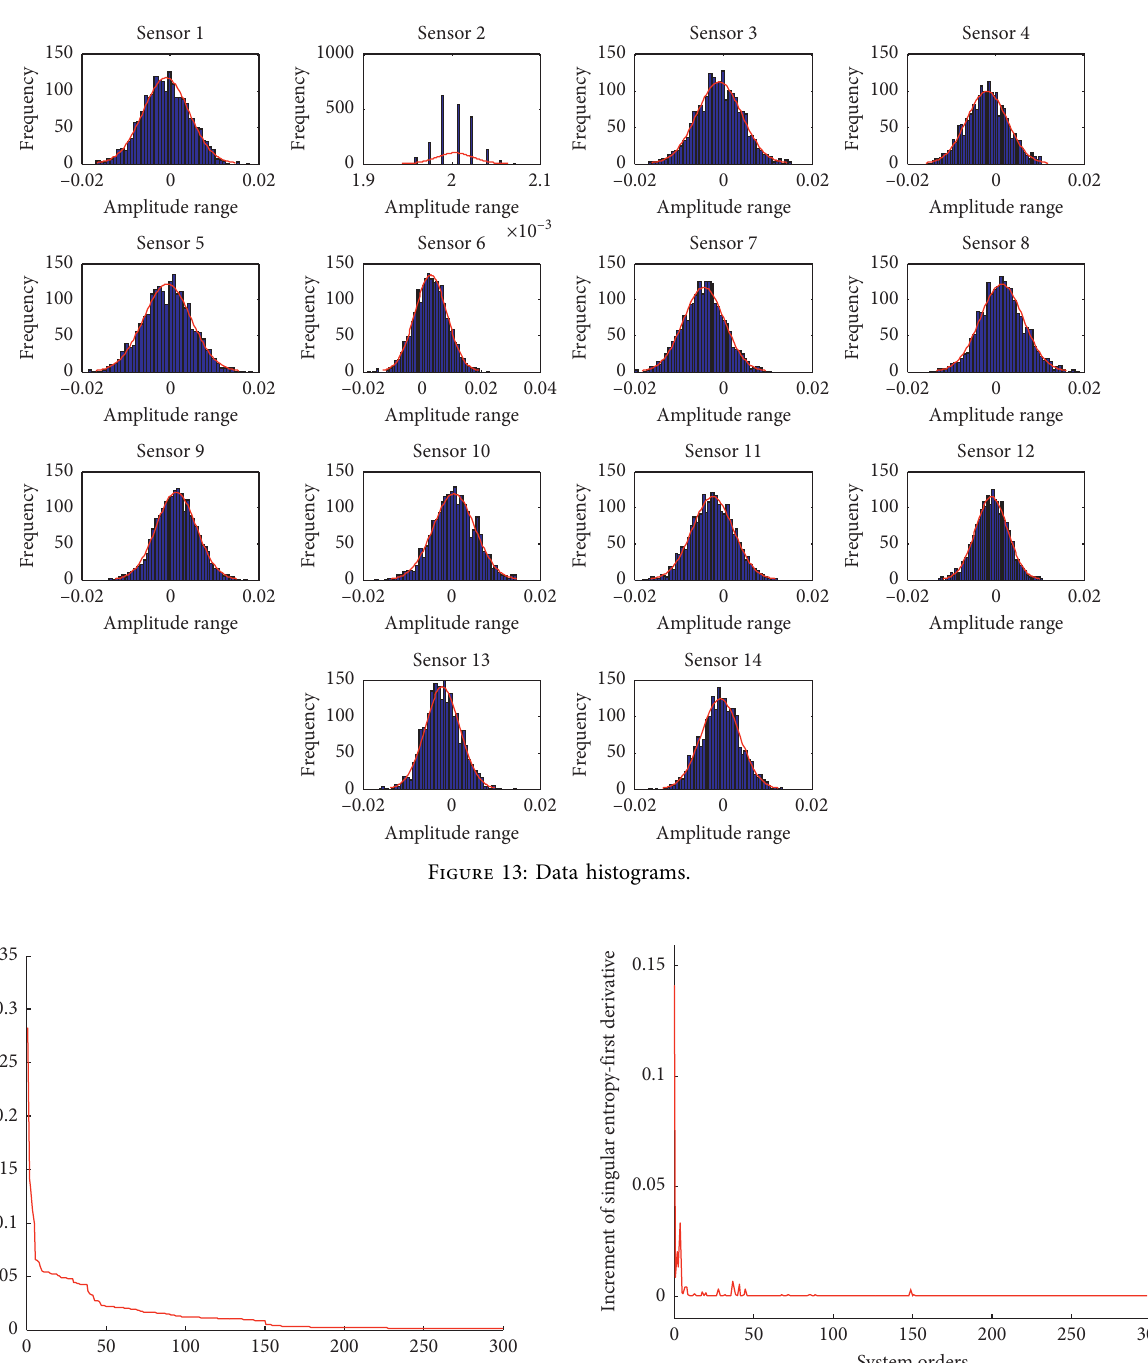
Figure 14: The trend of the change in singular entropy.